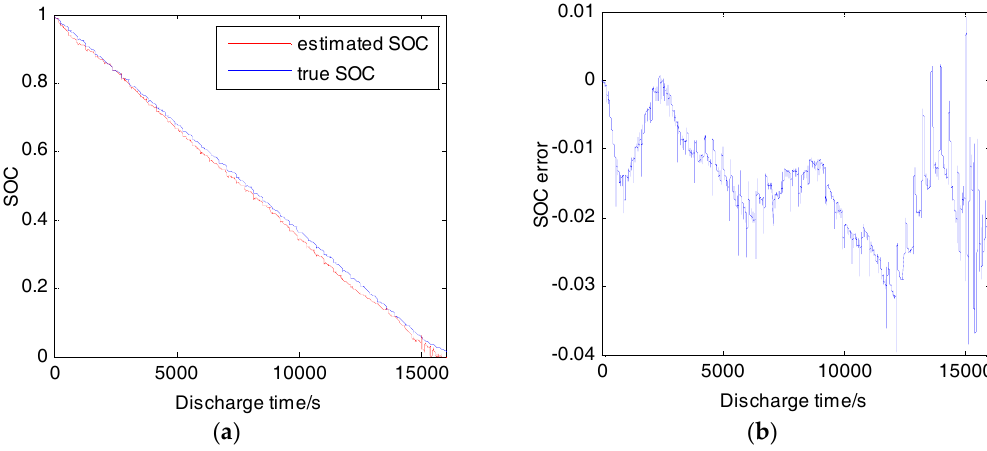
Figure 15. SOC estimation result (DST, 20 °C, measurement noise adjustment): ( a ) Estimated SOC and true SOC; ( b ) SOC estimation error.